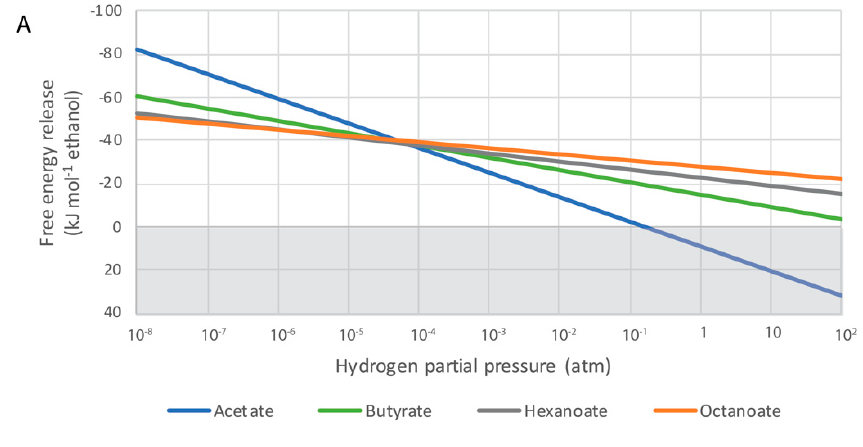
Figure 8. Free energy release for different products from ethanol under a range of H 2 partial pressures. Plots show the overall free energy release (A) and the free energy release per mol of ATP (B). Areas shaded in gray are considered infeasible and the dashed lines represent scenarios with Hyd1 as a hydrogenase instead of ECH. 5. Path Forward Taken together, the metabolic reconstructions and thermodynamic analysis suggests that (1) the most energetically advantageous products depend on enzymes other than those directly performing reverse β -oxidation, and (2) the infinite number of combinations of substrate ratios and product formation make simulating MCFA production a challenge. Still, as we learn more about the behavior of microbes producing MCFAs and how these microbes interact with complex microbial communities, we should improve our ability to design, diagnose, and control MCFA-producing bioreactors. We have identified specific knowledge gaps below. 5.1. Controlling Product Length Controlling the terminal product length remains a challenge. While we have illustrated that some conditions should favor the production of MCFAs over C2 and C4, almost all studies to date create mixtures of end products, varying in length from C2 to C6 or C8 (Table 3). The highest specificities of C6 and C8 production have resulted from the incorporation of pertraction systems [103]. This real-time removal of C6 and C8 is thought to increase their production in part because the protonated forms of MCFAs are toxic [104-106]. Thus, their production may be limited by their toxic effects. While there has been recent work on the toxic effects of these compounds in MCFA-producing bioreactors [107], an improved understanding of the toxicity of these products is needed. Quantifying these effects, for instance via Monod-based inhibition terms, would be particularly valuable